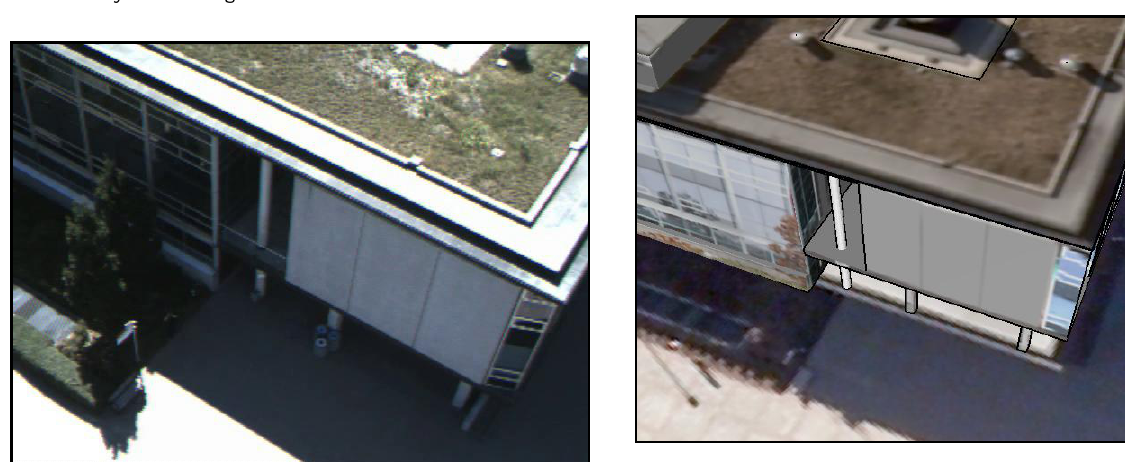
Figure 5. Sample video frame (640 x 480 pixels)